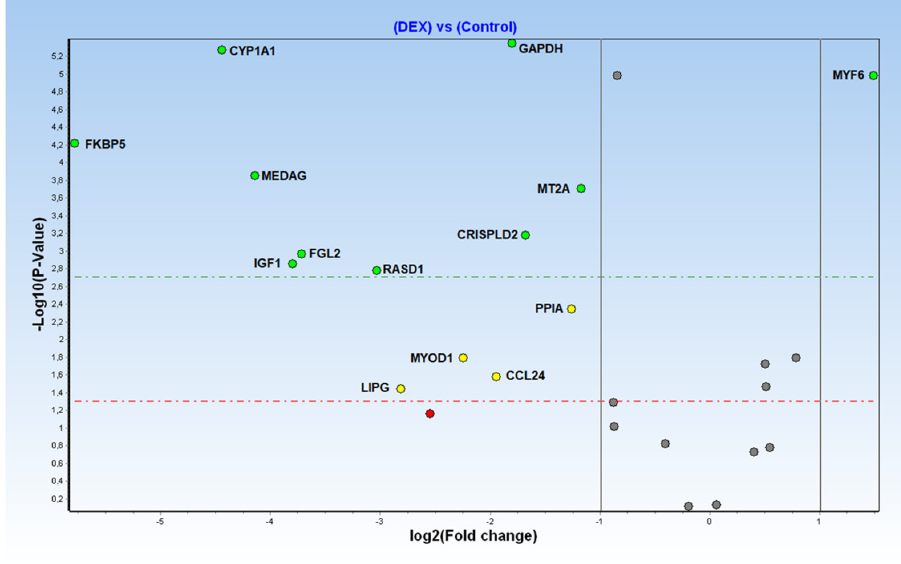
Figure 2. Volcano plot of Fold Changes (X axis, logarithmic scale) and related p -values (Y axis, logarithmic scale) for all considered transcriptional biomarkers.